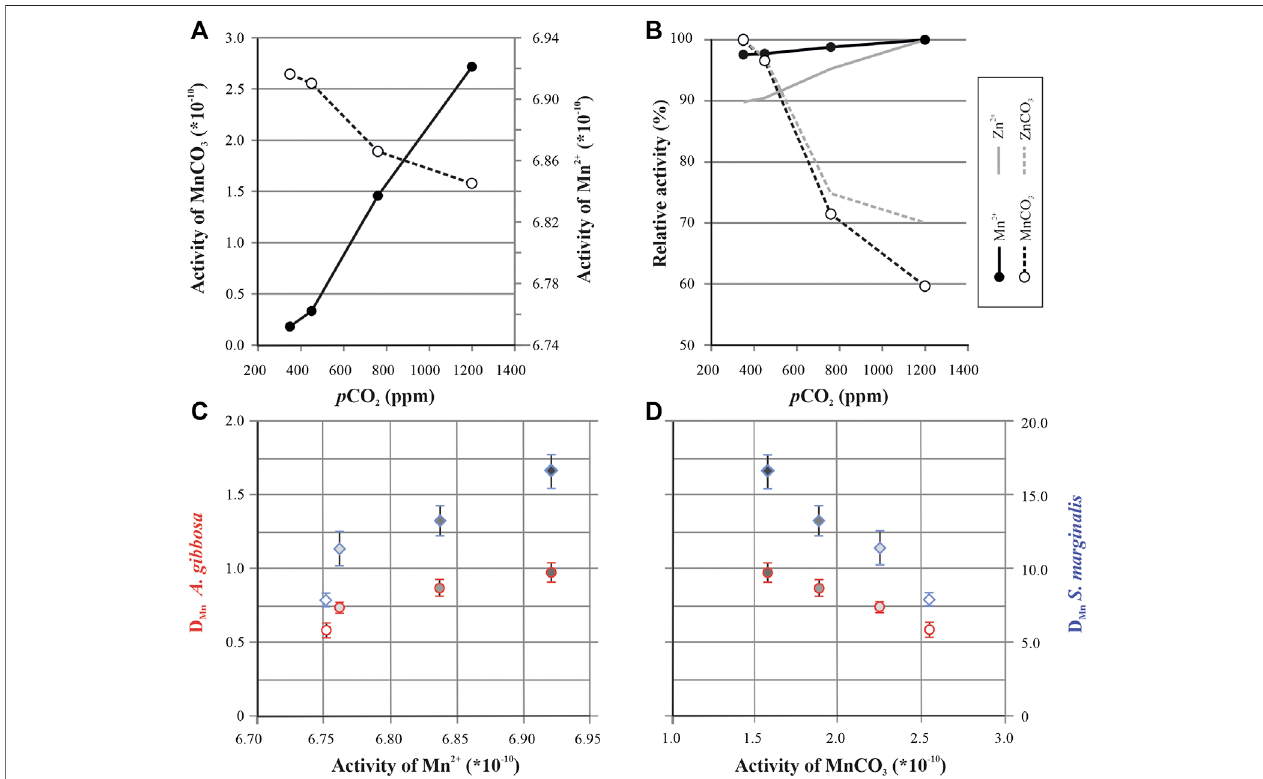
FIGURE 5 | Modeled activity of Mn by PHREEQC. Speciation of free (Mn 2+ ; closed symbols) and complexed (MnCO 3 ; open symbols) Mn plotted as a function of pCO 2 (A) . Relative change in activity of free Mn 2+ and Mn-CO 3 complexes (B) plotted together with relative activity changes of free Zn 2+ (solid gray line) and ZnCO 3 complexes (dashed gray line) from van Dijk et al. (2017c). Mn partitioning for both species ( A. gibbosa (cid:1) red circles; Sorites marginalis (cid:1) blue diamonds) as a function of Mn 2+ activity (C) andMnCO 3 activity (D) ,withsymbol fi llingcorrespondingto p CO 2 ofthetreatments,inwhichdarker fi llingrepresentshigher p CO 2 conditions,see also Figure 2 .